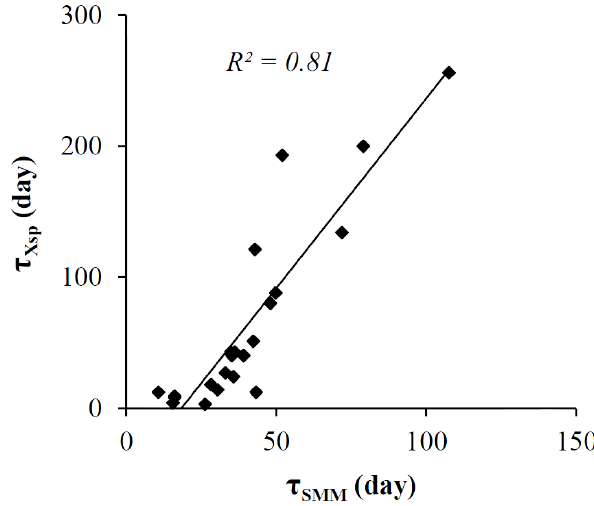
Figure 4. Relationship between basin-wise soil moisture memory and XAJ model spin-up